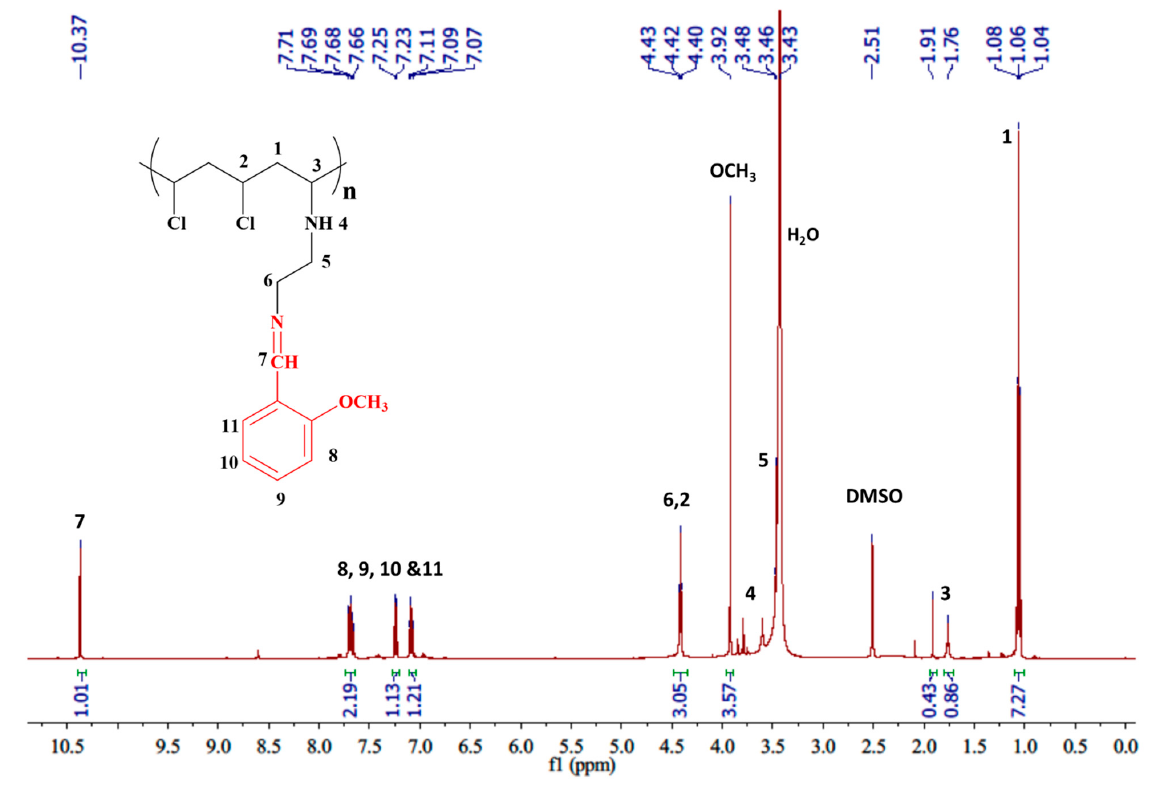
Figure 1. 1 H NMR spectrum of PVC-ed/o-OMe.